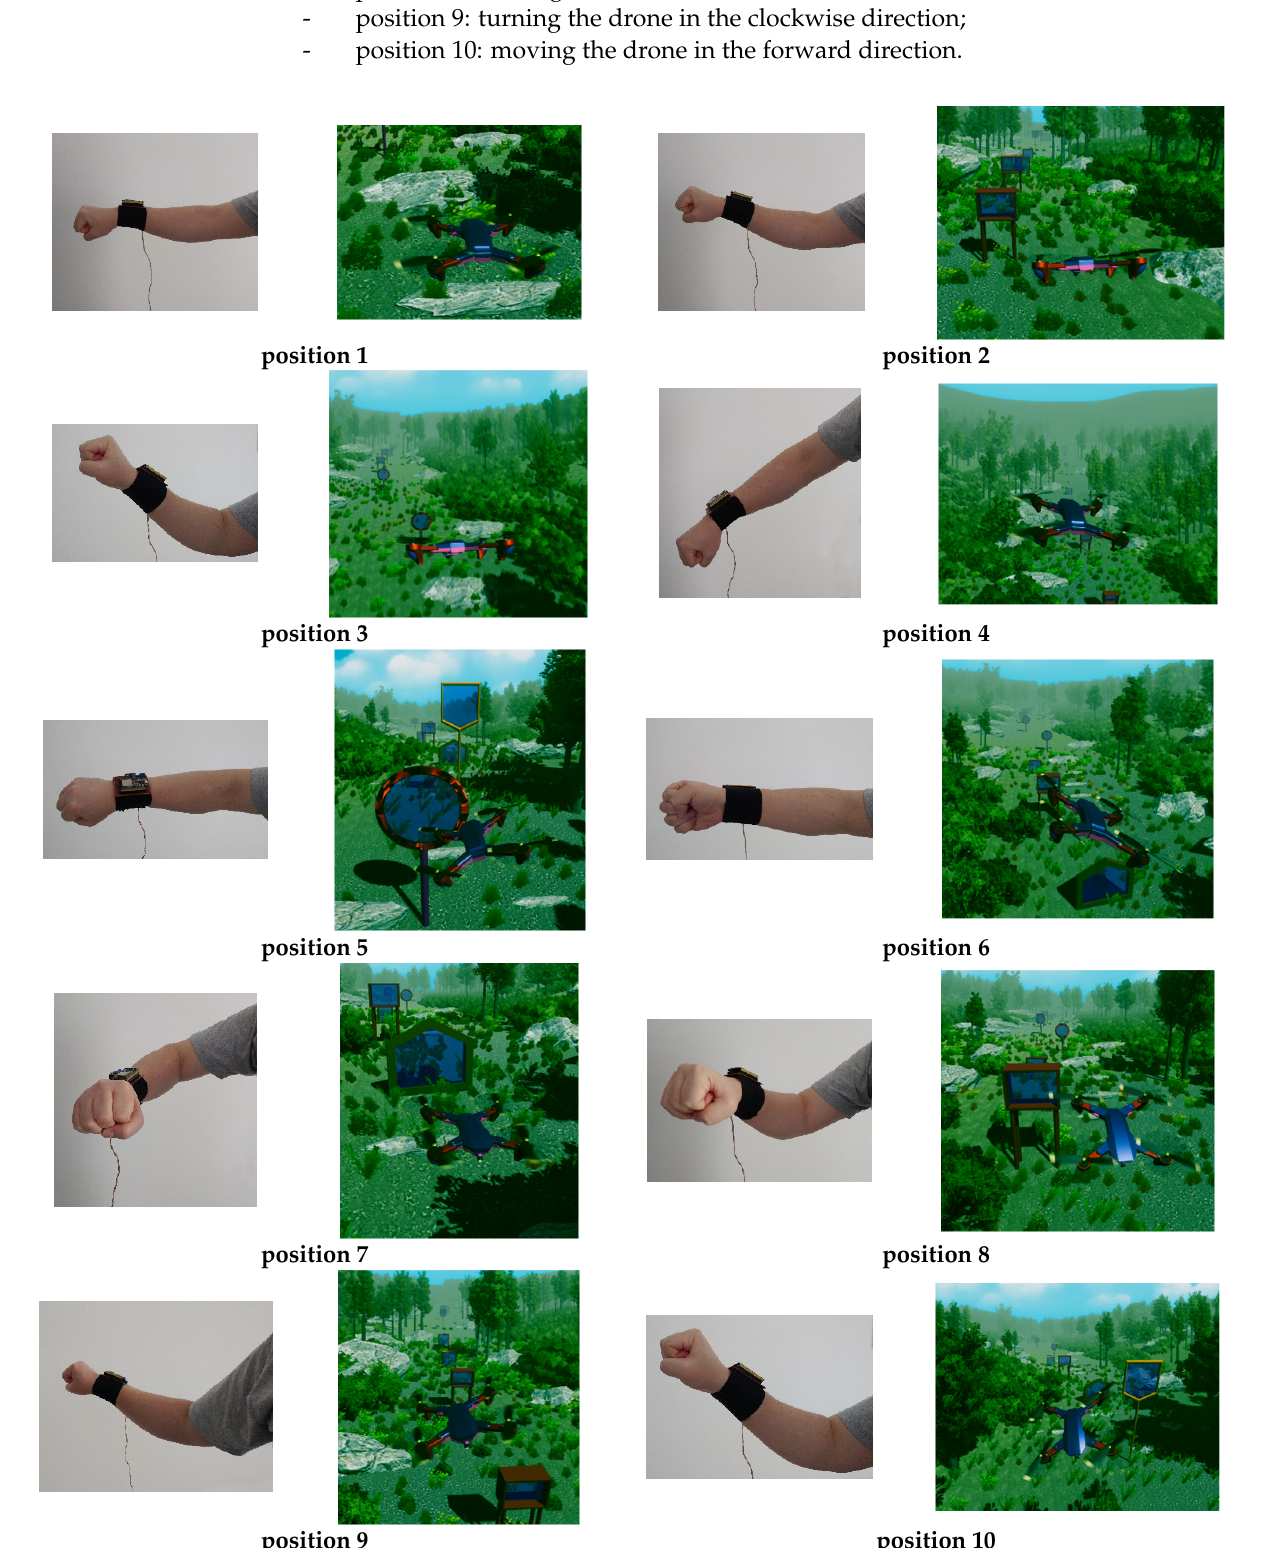
Figure 16. Drone control positions.